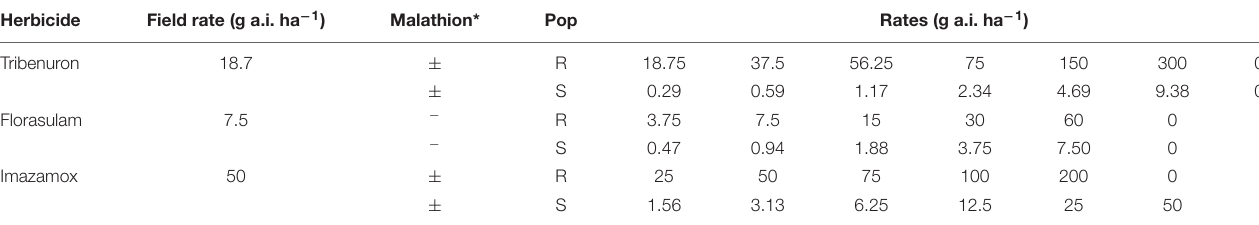
TABLE 1 | Herbicide range of doses applied to resistant (R) and susceptible (S) populations with or without malathion. Herbicide Field rate (g a.i. ha − 1